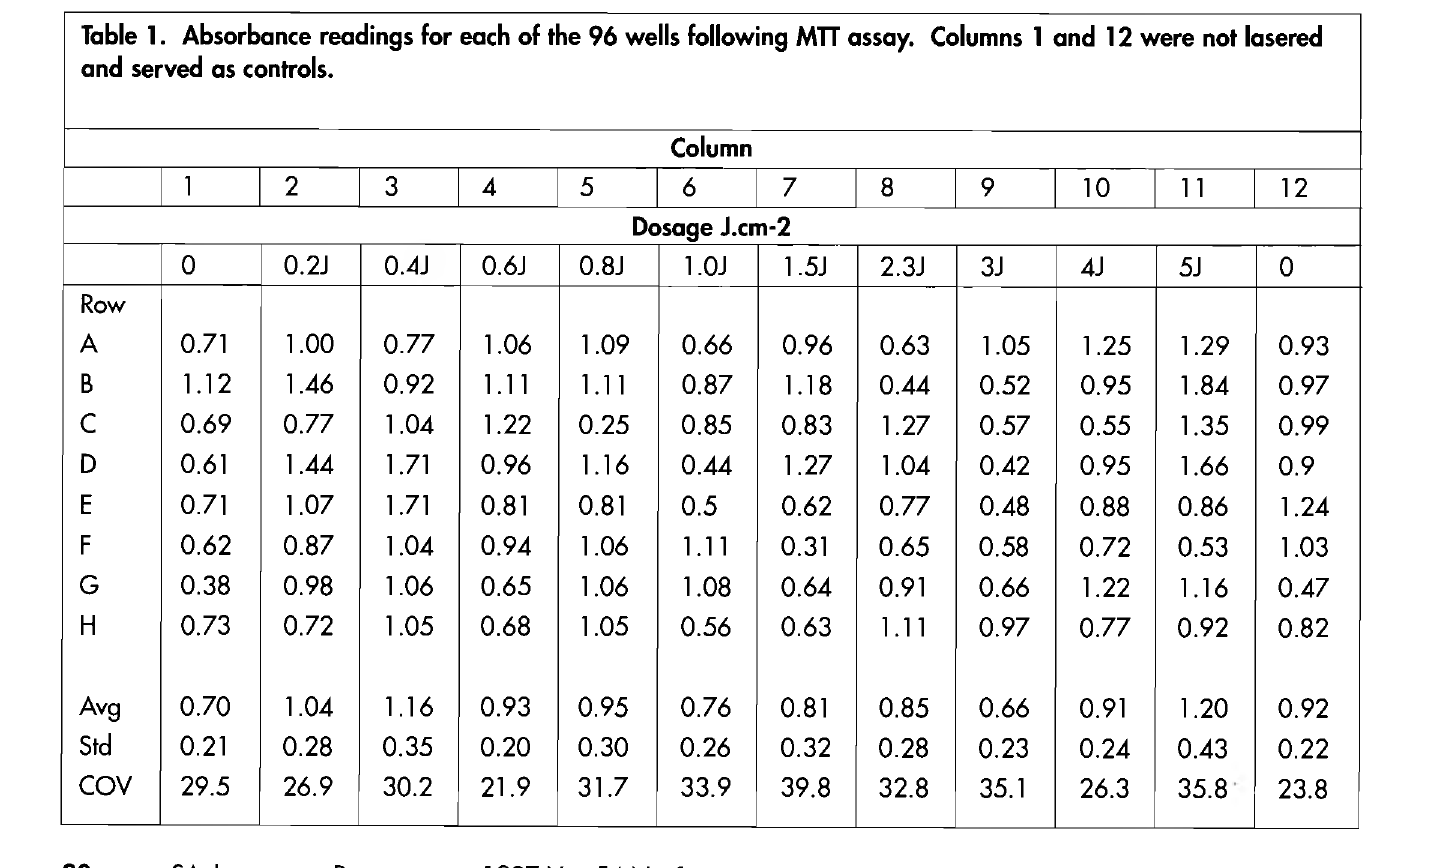
Table 1. Absorbance readings for each of the 96 wells following MTT assay. Columns 1 and 12 were not lasered and served as